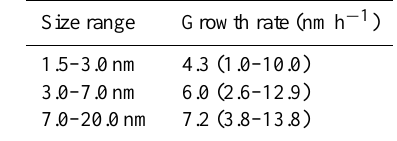
Table 2. The formation rates of all clusters and ions during NPF events. The median values and the range from 5th to 95th percentile are shown. The formation rates of all clusters at 1.6nm were deter- mined from PSM data. The formation rates of ions at 1.6nm and all clusters and ions at 2nm were determined from NAIS